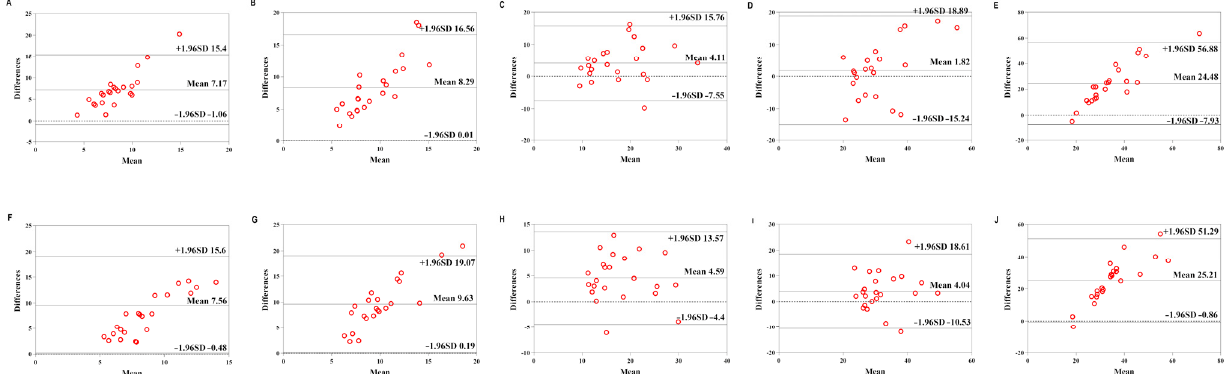
Figure 7. Comparison between the Lexin Mio smart bracelet (Mio) and gas-analysis system (GAS) for energy expenditure (EE) in the middle-physical-activity level (MPAL) group. ( A ) Bland–Altman plots of mean of left Mio and GAS for EE under rest condition. ( B ) Bland–Altman plots of mean of left Mio and GAS for EE under the low-intensity exercise. ( C ) Bland–Altman plots of mean of left Mio and GAS for EE under the middle-intensity exercise. ( D ) Bland–Altman plots of mean of left Mio and GAS for EE under the high-intensity exercise. ( E ) Bland–Altman plots of mean of left Mio and GAS for EE under recovery condition. ( F ) Bland–Altman plots of mean of right Mio and GAS for EE under rest condition. ( G ) Bland–Altman plots of mean of right Mio and GAS for EE under the low-intensity exercise. ( H ) Bland–Altman plots of mean of right Mio and GAS for EE under the middle-intensity exercise. ( I ) Bland–Altman plots of mean of right Mio and GAS for EE under the high-intensity exercise. ( J ) Bland–Altman plots of mean of right Mio and GAS for EE under recovery condition. In the MPAL group, the p value of the t -test ranged from <0.001 to 0.326 ( p < 0.05, except for the left Mio at high intensity), the MAPE ranged from 16.4% to 32.42% (MAPE > 10%), the Pearson’s correlation coefficients ranged from 0.166 to 0. 739 ( p < 0.05, except for the left Mio at baseline and the right Mio at baseline), and the ICC ranged from 0.096 to